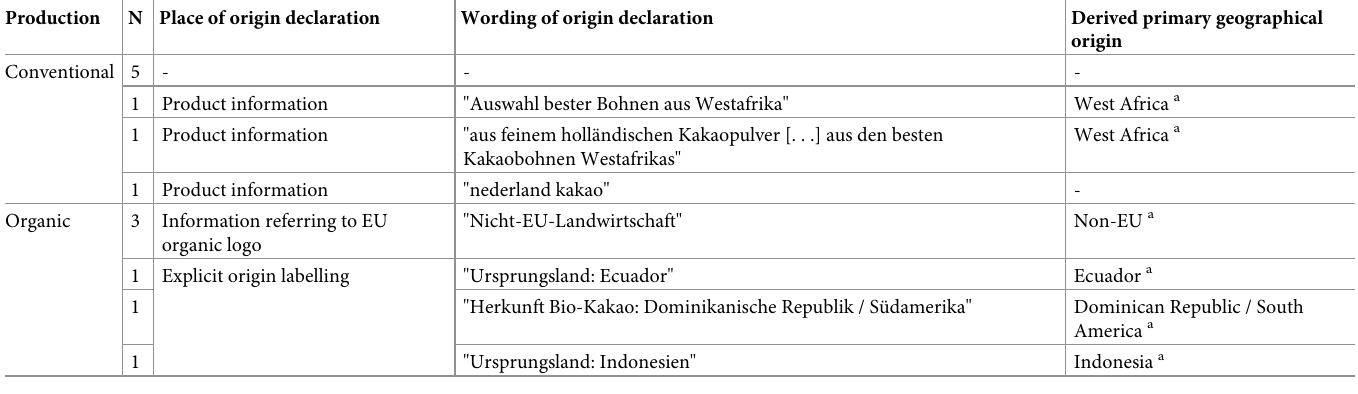
Table 7. Labelled origin information for cocoa powder launched on the German market between January 1996 and May 2018 according to Mintel Global New Prod- uct Database (GNPD). N number of products listed with photos of packaging in Mintel GNPD [40].